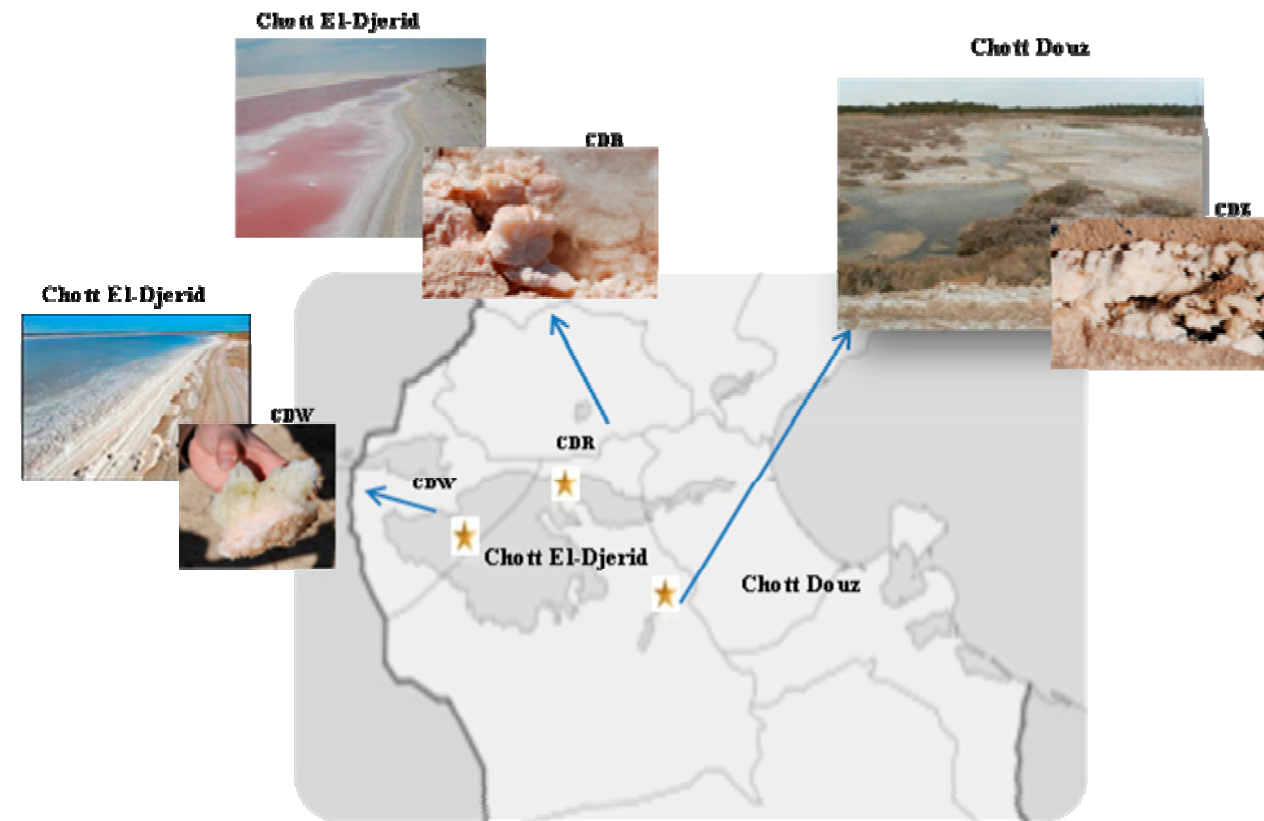
Figure 1. Site map of the different sampling stations. Station 1: Chott El-Djerid (CDR) (N 33 ◦ 58 (cid:48) 736”, E 08 ◦ 20 (cid:48) 632”, Alt 48 ft/14.6 m); Station 2: Chott El-Djerid (CDW) (N 33 ◦ 57 (cid:48) 252”, E 08 ◦ 24 (cid:48) 507”, Alt 7 ft/2 m); Station 3: Chott Douz (CDZ) (N 33 ◦ 26 (cid:48) 753”, E 09 ◦ 00 (cid:48) 814”, Alt 173 ft/53